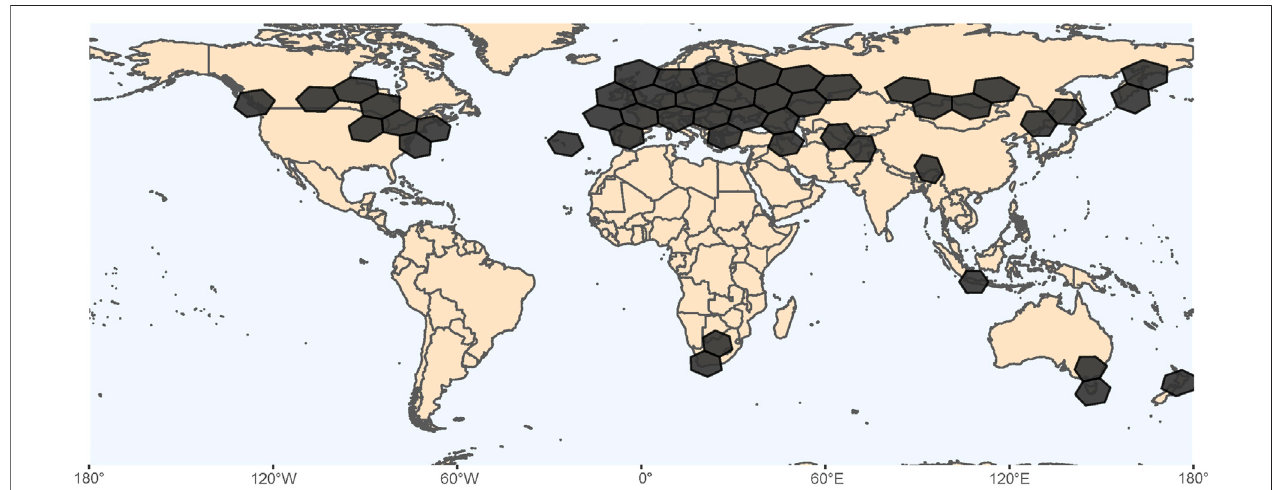
FIGURE 3 | Geographic distribution of Lumbriculus spp, based on occurrence records found at the Global Biodiversity Information Facility (GBIF.org, 2021). Hexagons in South Africa, Indonesia, Australia and New Zealand represent 98 records that would need additional veri fi cation.